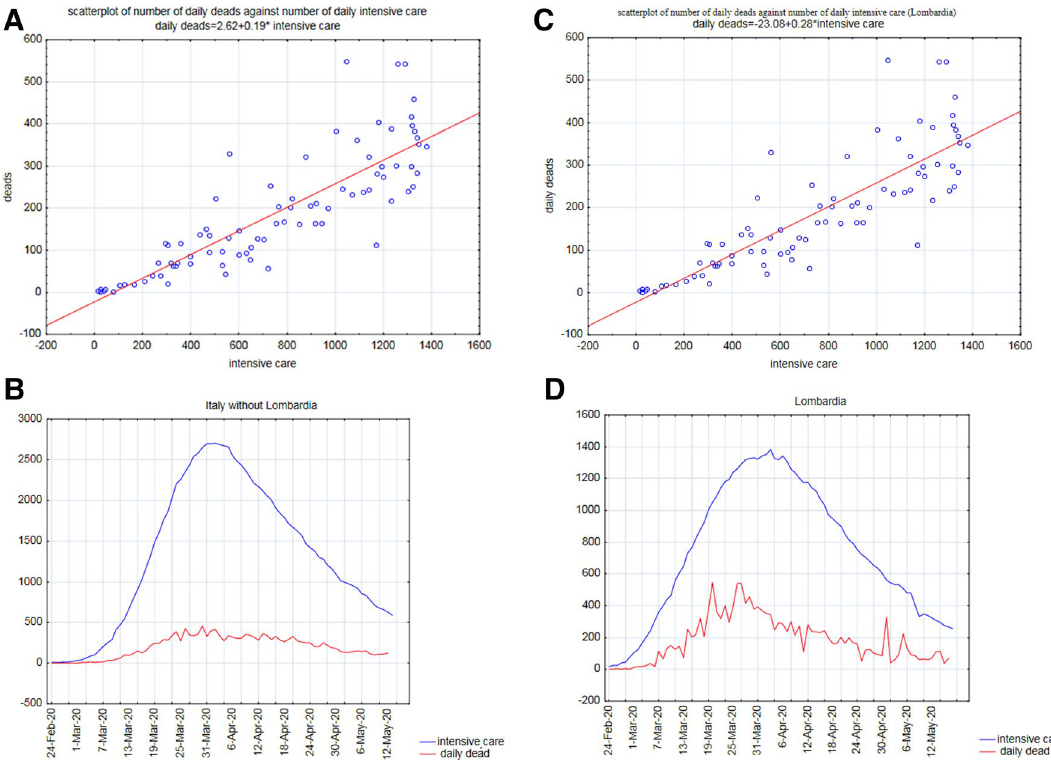
Figure 3. (A,B) Report the regression line linking the number of patients in intensive care units (ICUs) and the number of dead on a day-by-day basis for both Lombardia and Italy. (C,D) Report the daily variation of dead and ICUs for Lombardia and Italy, respectively. It is worth noting both dead and ICUs follow almost perfectly the epidemic